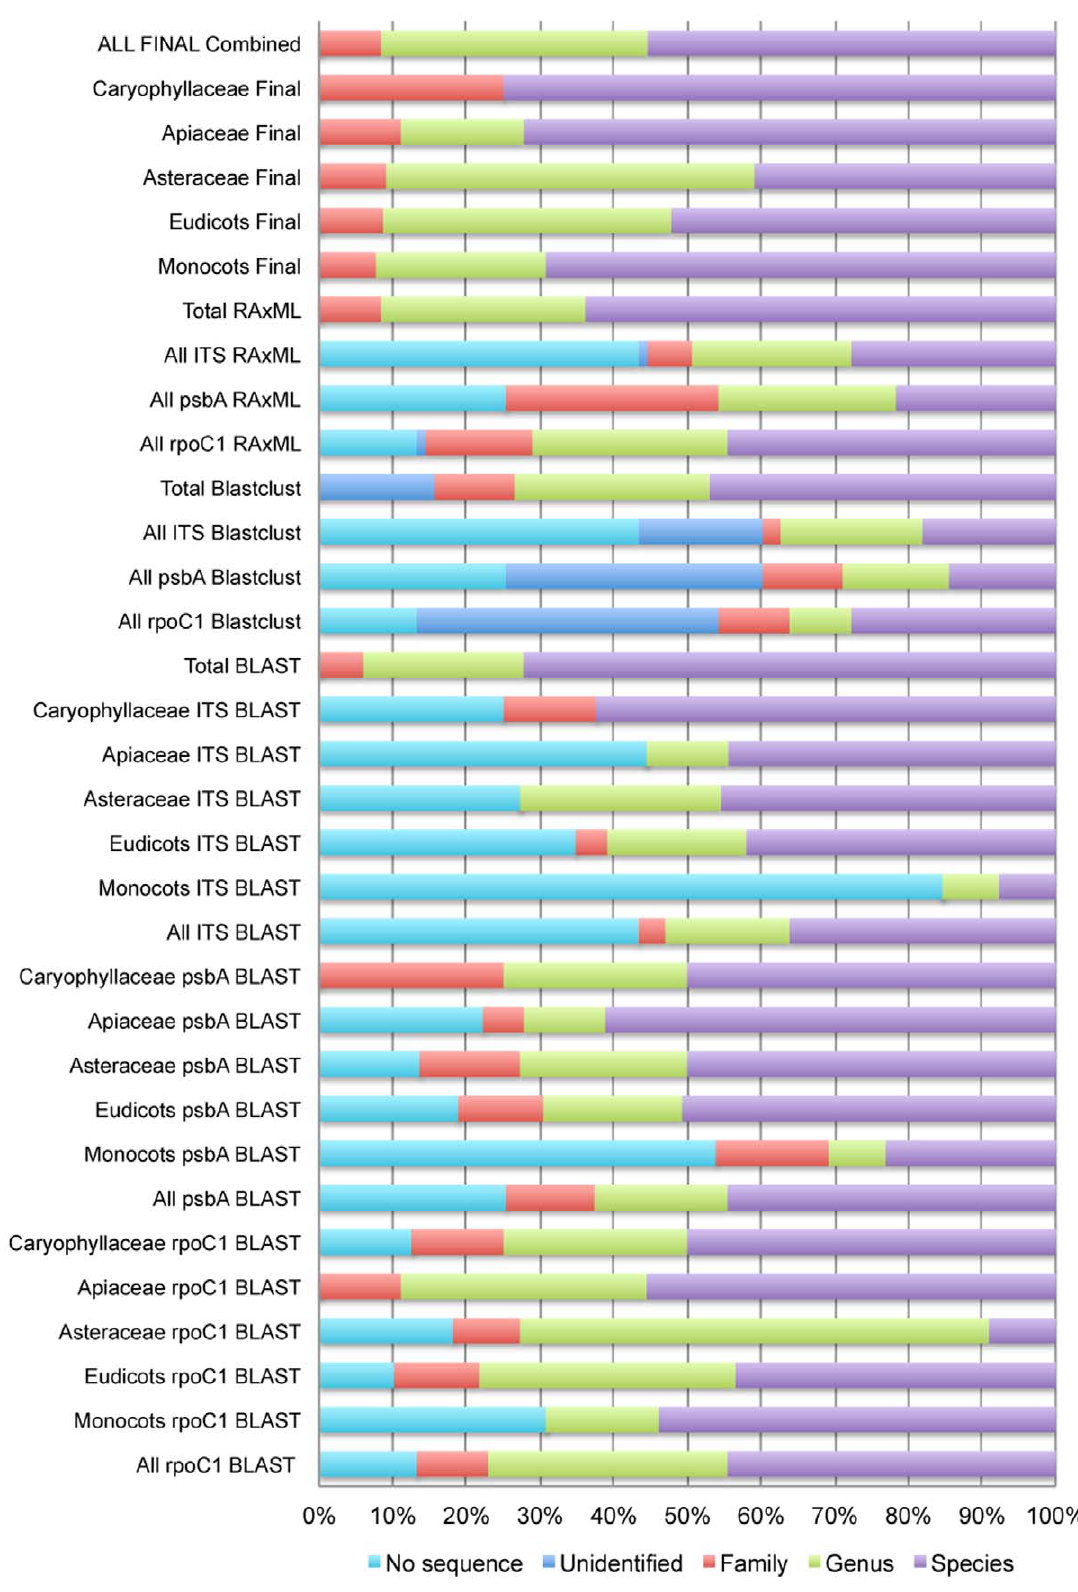
Figure 2. Relative identification success per marker, analysis method and taxonomic group.